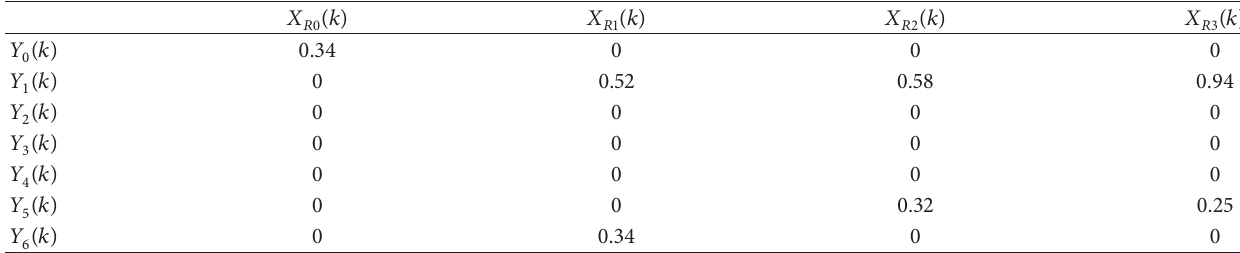
Table 15: The output matrix C 𝐸